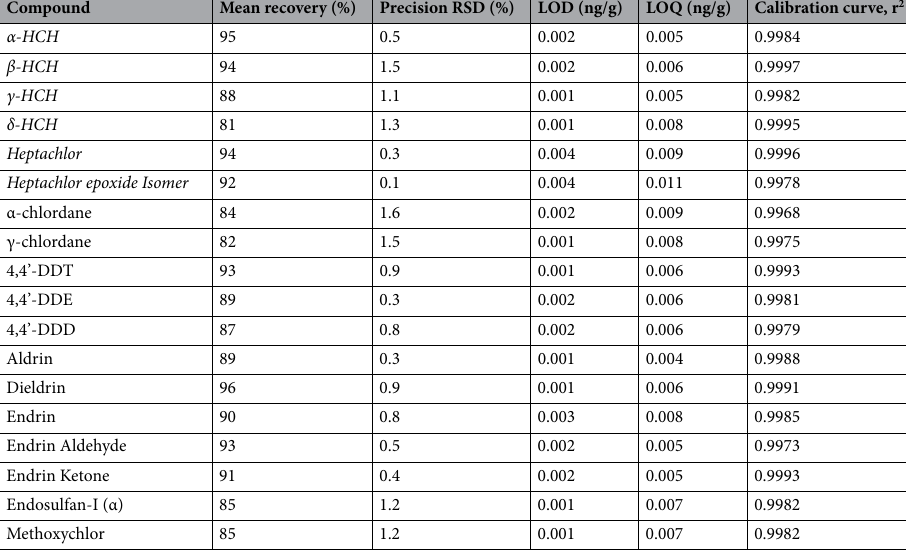
Table 1. Mean recovery, relative standard deviation (RSD) and limit of detection (LOD) of OCPs.